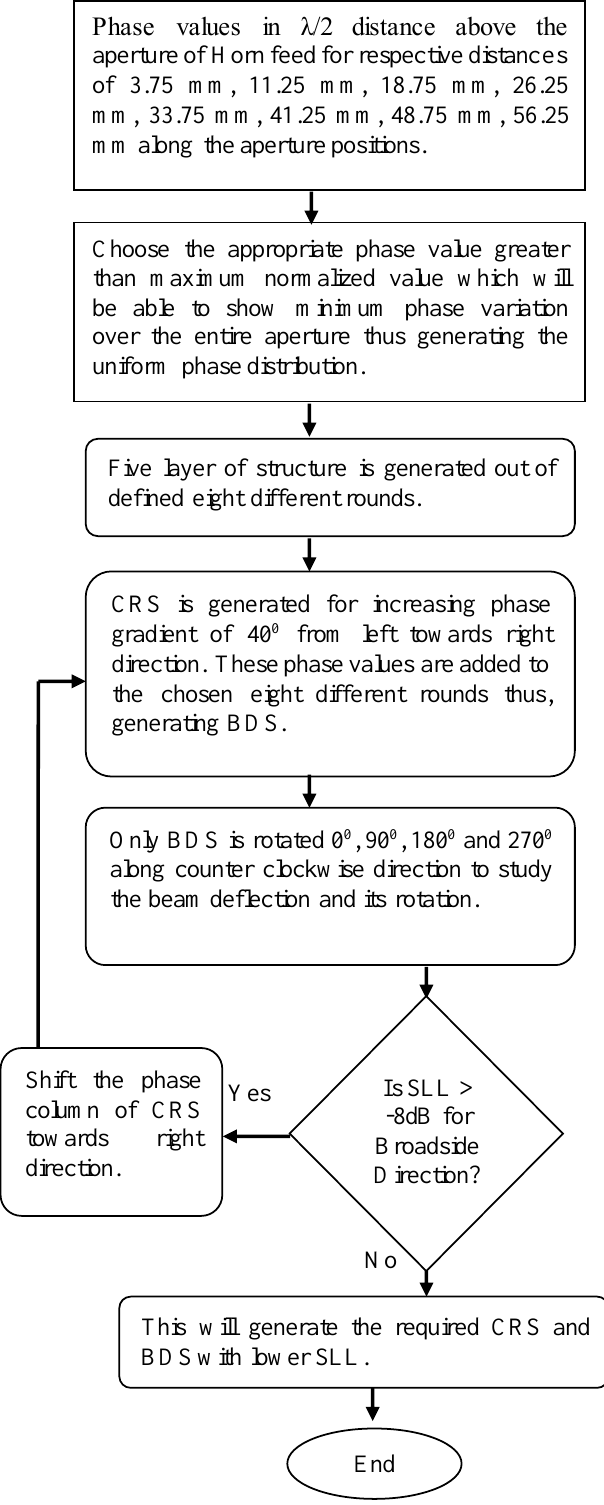
Figure 5. Flowchart describing the generation of BDS